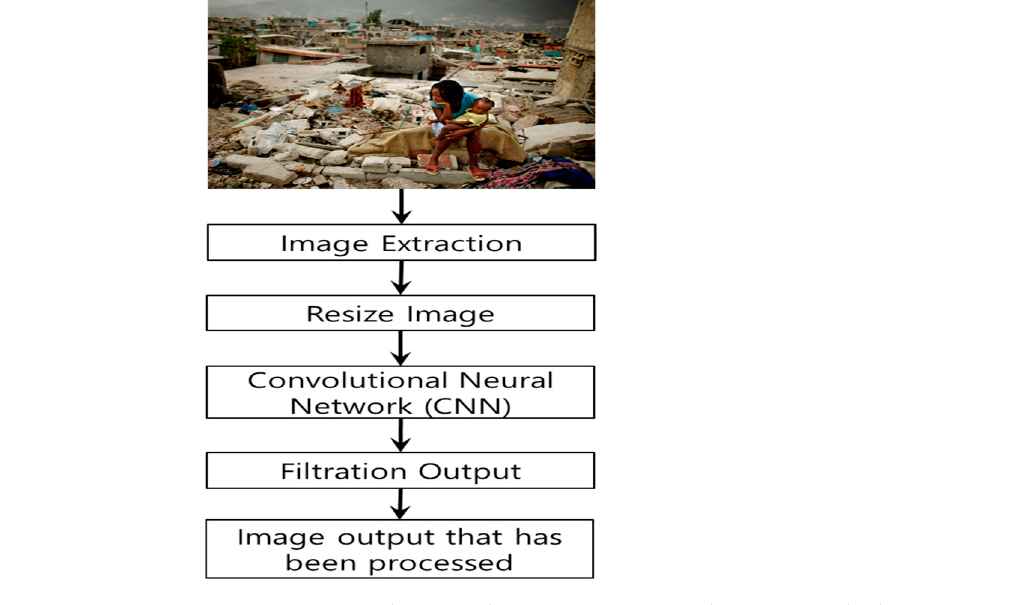
Figure 2. Steps in detecting disaster victims using the YOLO method.